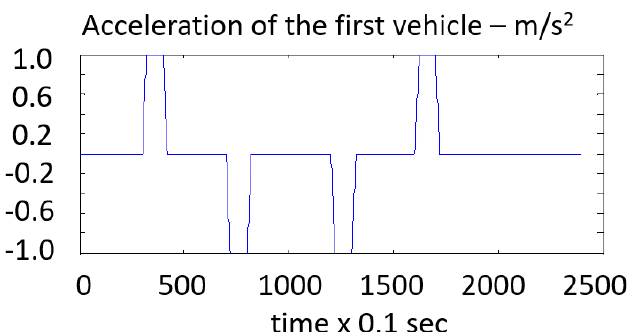
Figure 18. Acceleration, deceleration of the first drone applied in verification tests.